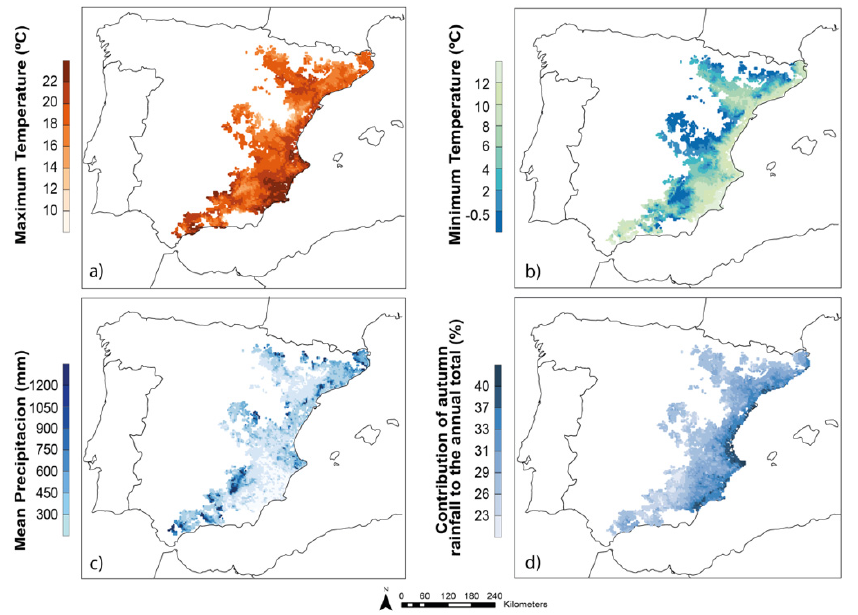
Figure 3. Climate characteristics of the study area. ( a ) Maximum temperatures, ( b ) minimum temperatures, ( c ) mean annual precipitation, and ( d ) percentage contribution of autumn precipitation to the total precipitation.